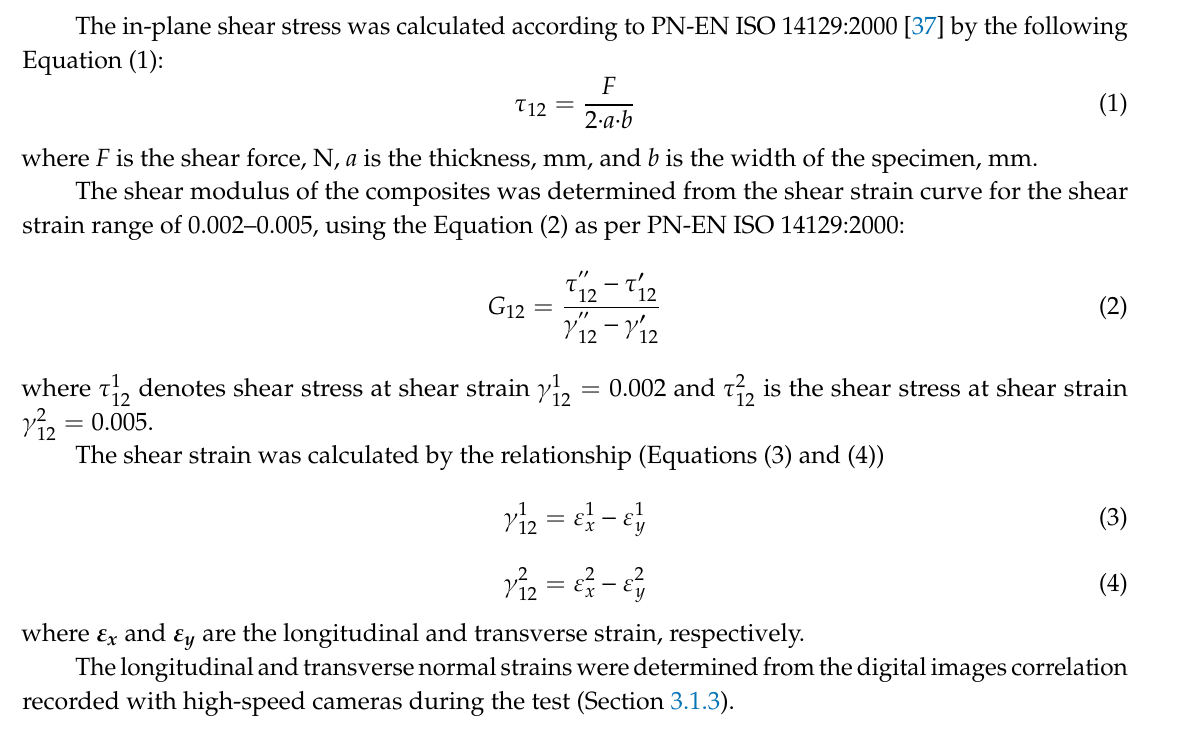
Figure 4. Experimental setup for in-plane shear test in a ±45° off-axis tension: view of the tensile machine with two cameras equipped Aramis system ( a ), in-plane shear sample covered with grey scale pattern ( b ), schematic representation of in-plane shear sample with sample orientation (warp, weft, x, y), applied force (F) and measured strains ( ε x , ε y ) ( c ).